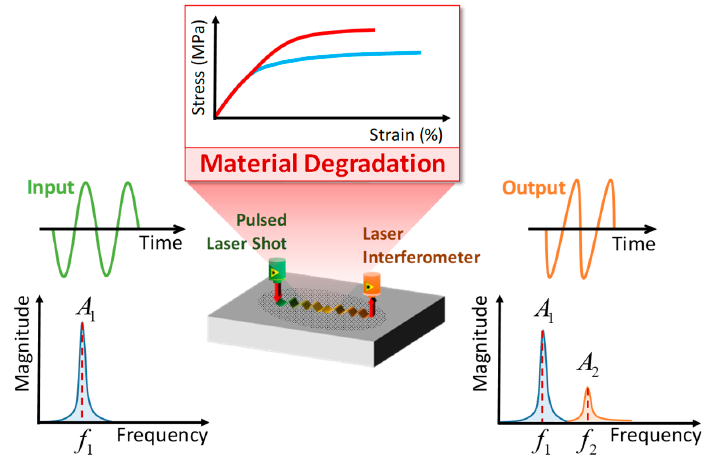
Figure 5. The second-order harmonic frequency component generation due to acoustic nonlinearity.